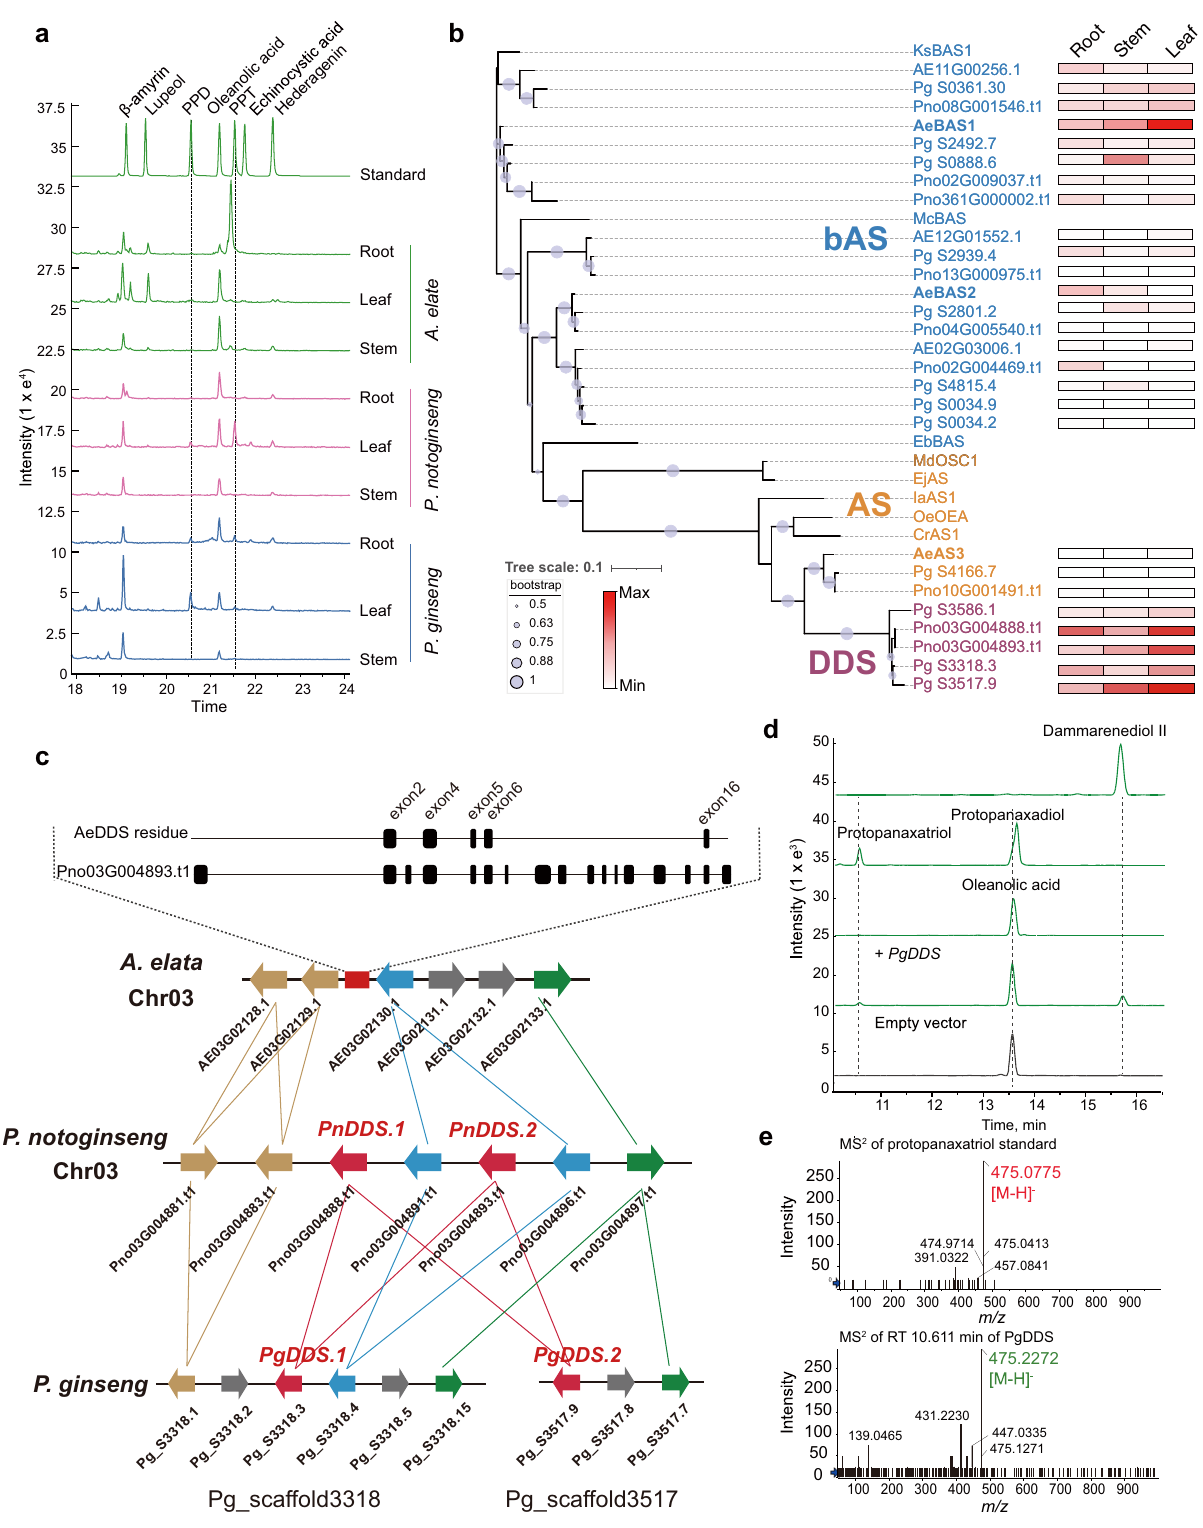
Fig. 3 The loss of DDS gene in the genome of A. elata . a GC – MS analysis of triterpenoid contents in A. elata , P. notoginseng , and P. ginseng . b Phylogenetic tree of BAS, AS, and DDS family proteins in P. ginseng , P. notoginseng, and A. elata . The phylogenetic tree was constructed using the maximum likelihood method, in which tree nodes (>50%) are indicated by purple dots on branches (1000 bootstrap replications). The heatmap on the right shows the FPKM values of gene expression in the roots, stems, and leaves of A. elata . c Syntenic analysis of DDS genes in P. ginseng , P. notoginseng , and A. elata . The red rectangle indicates the position of DDS residues, the rounded rectangles in the dashed box indicate exons, the lines indicate genes with colinearity, and the red lines indicate the colinear relationships of DDS genes between P. notoginseng and P. ginseng . d , e LC – MS analysis of triterpenoid contents of Aralia elata callus overexpressing PgDDS . Source data underlying b are provided as a Source Data fi